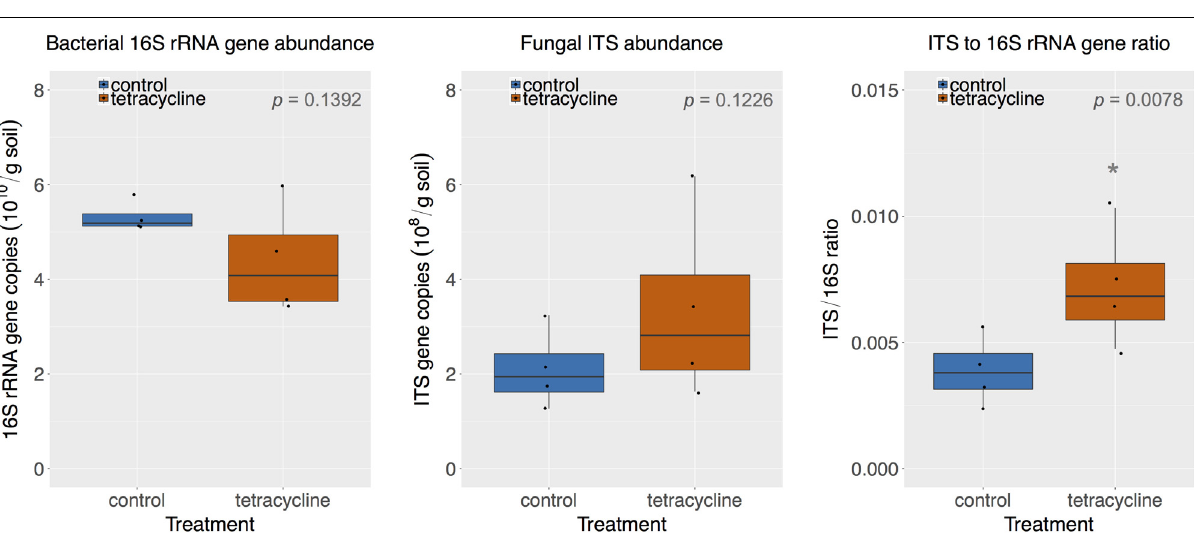
FIGURE 2 | Comparison of bacterial 16S rRNA gene and fungal ITS abundance in control (blue) and tetracycline (red) samples. Significant difference between control and tetracycline treatment is marked with ∗ (paired t -test, p < 0.05). Each sample is represented by one point. The boxes represent the first and third quartiles, with median value bisecting each box. The whiskers extend to the largest/smallest value, excluding outliers (data beyond 1.5 × inter-quartile